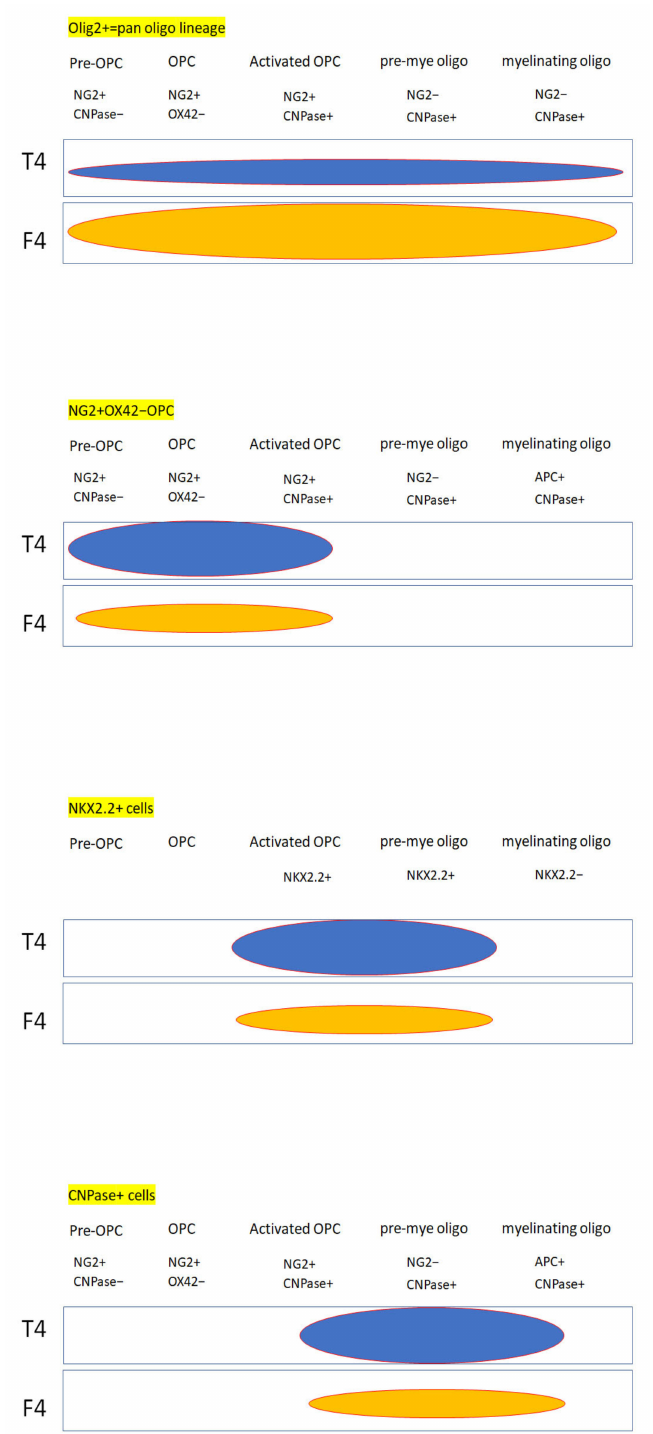
Figure 18. Comparison of differential markers expressed by the transected spinal cord and those treated with